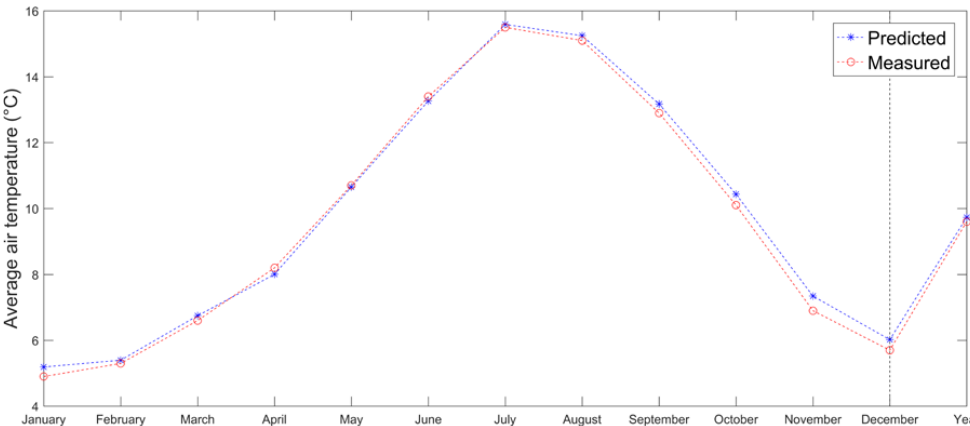
Figure 10. Estimated and measured monthly average air temperatures for Birr (Ireland) meteorological station using monthly lapse rates.